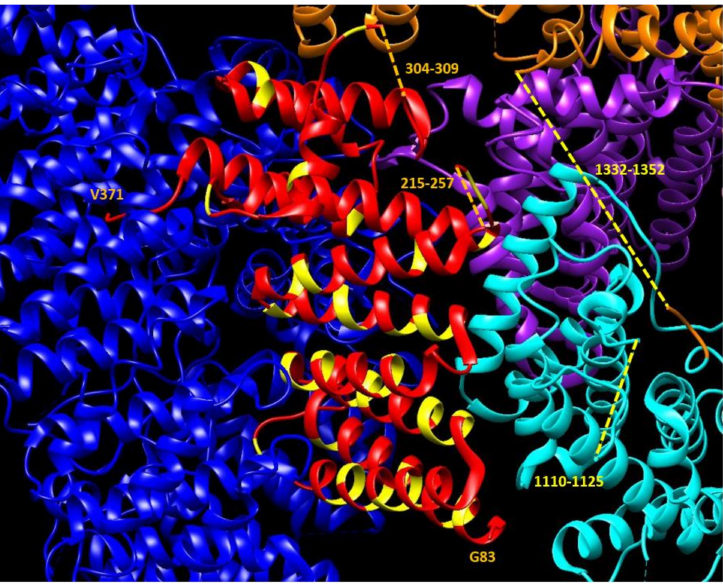
Figure 2. Detail of HAP40 bound to HTT. HAP40 interacts very tightly with the C -terminal domain of HTT (blue). The C -terminal V371 of HAP40 is inserted into the moiety of HEAT repeats. No disordered insertions are noted in this interface. Note the contrast with the interface of interaction between HAP40 and the HTT cyan domain. The side facing the viewer contains two unmodeled regions in HAP40 (orange dashed lines) and two in HTT (yellow dashed lines). These intrinsically disordered regions (IDRs) are likely to interact in 3D. All alanines in HAP40 have been colored in yellow to note that the C -terminal A-rich region belongs to the part of HAP40 facing away from the core of